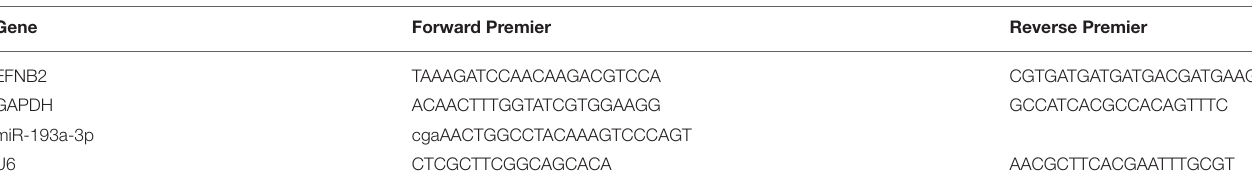
TABLE 1 | Primer sequences for qRT-PCR analysis. Gene Forward Premier Reverse Premier